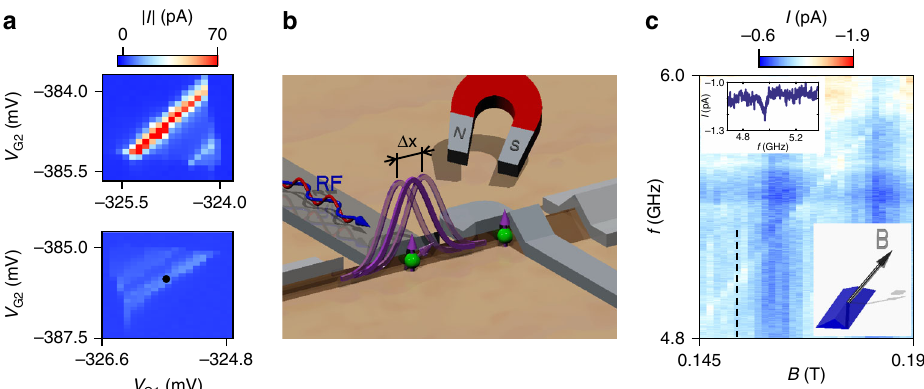
Fig. 3 EDSR spectroscopy. a Set of bias triangles from device C for V SD = 1 mV (upper panel) and V SD = − 1 mV (lower panel). b Illustration showing the principle of EDSR. An RF signal applied to the top gate can change the position of the hole wave function. Such an oscillating motion in combination with a static magnetic fi eld can lead to spin rotations for a system with strong spin-orbit coupling. c Raw data measurement showing the frequency versus magnetic fi eld dependence of the zero detuning current measured at the position marked by the black circle in a . For a reversed bias voltage no such EDSR response could be observed (Supplementary Fig. 2). The magnetic fi eld is oriented 45° in respect to both the out-of-plane direction and the in-plane HW axes (see lower inset). The upper inset shows a line trace taken along the black dashed bias voltages of − 2 mV and + 2 mV, respectively. The corre- sponding line traces along the detuning direction (white dashed lines) are plotted below in Fig. 2c. In the blocked con fi guration (blue squares, dotted line) the zero-detuning current, indicated by the black arrow, drops to about 2 pA compared to 10 pA in the non-blocked case (green triangles, solid line), as expected for PSB 23 . The magnetic fi eld dependence of the leakage current in the blocked con fi guration is shown in Fig. 2d for an out-of-plane magnetic fi eld. The clear increase of the leakage current at elevated magnetic fi elds is an indication for a spin-orbit induced lifting mechanism of PSB 27,28 , though this is expected already at much lower magnetic fi elds. At zero magnetic fi eld, no nuclear-spin induced current peak can be observed 23 , which indicates a low hyper fi ne interaction.